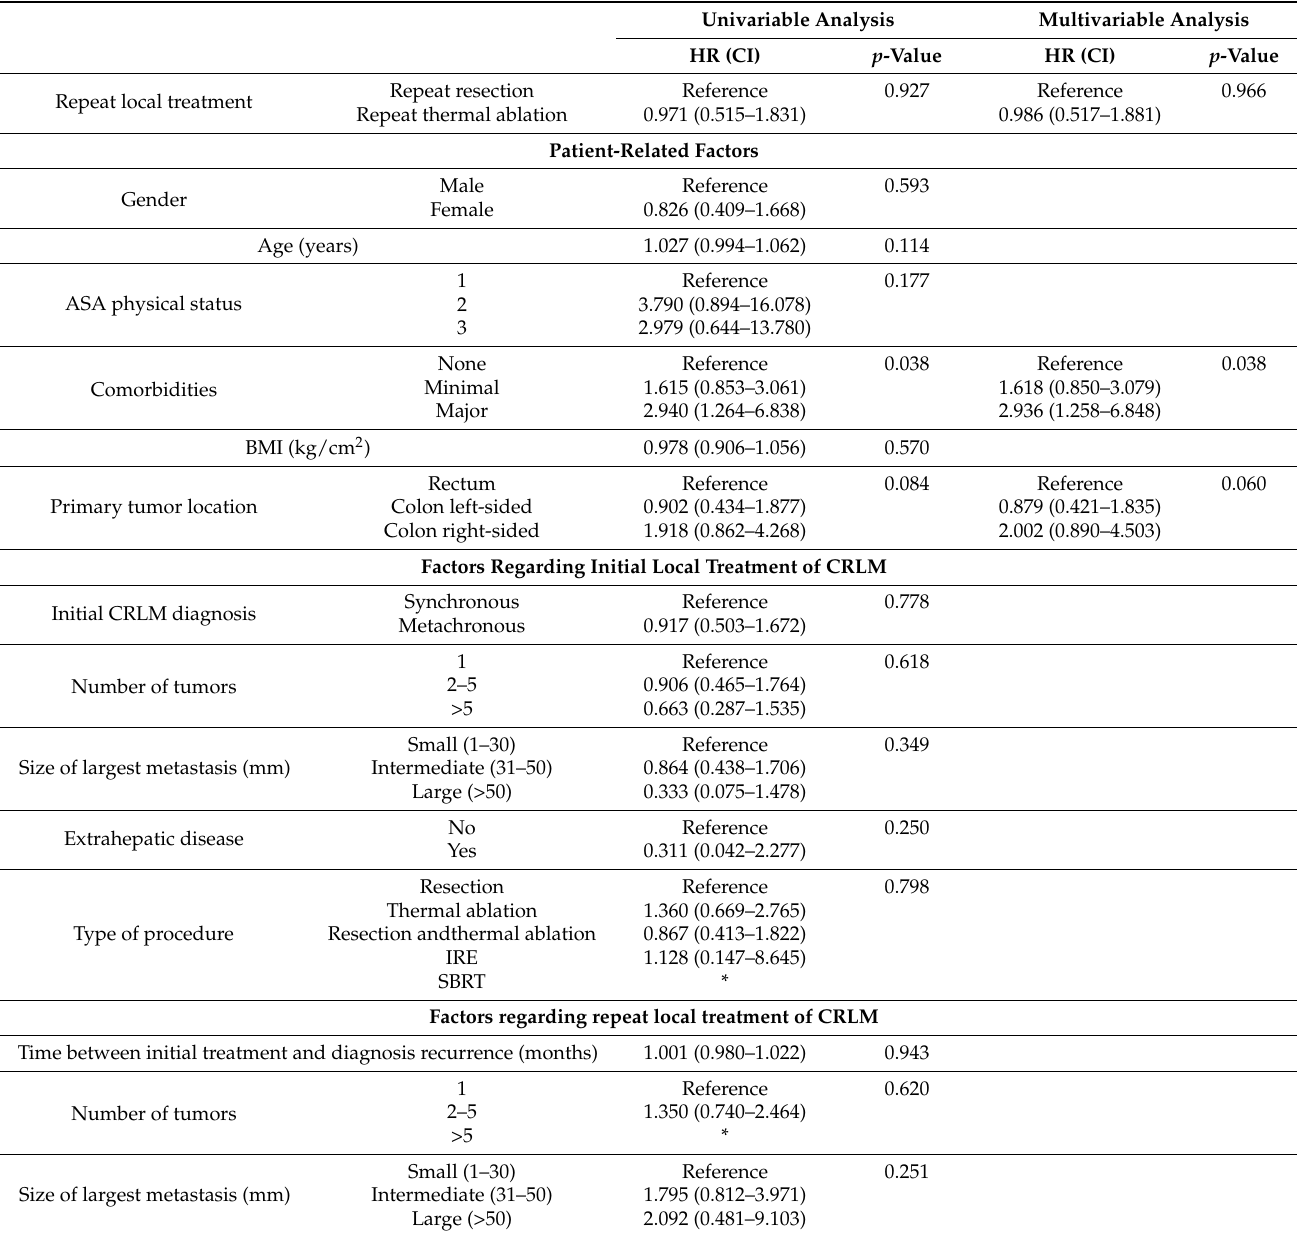
Table 4. Univariable and multivariable cox regression analysis to detect potential confounders associated with overall survival (OS). After removal of primary tumor location and adjusting for the confounder comorbidities, corrected HR of repeat local treatment was 0.986 (95% CI, 0.517–1.881; p =